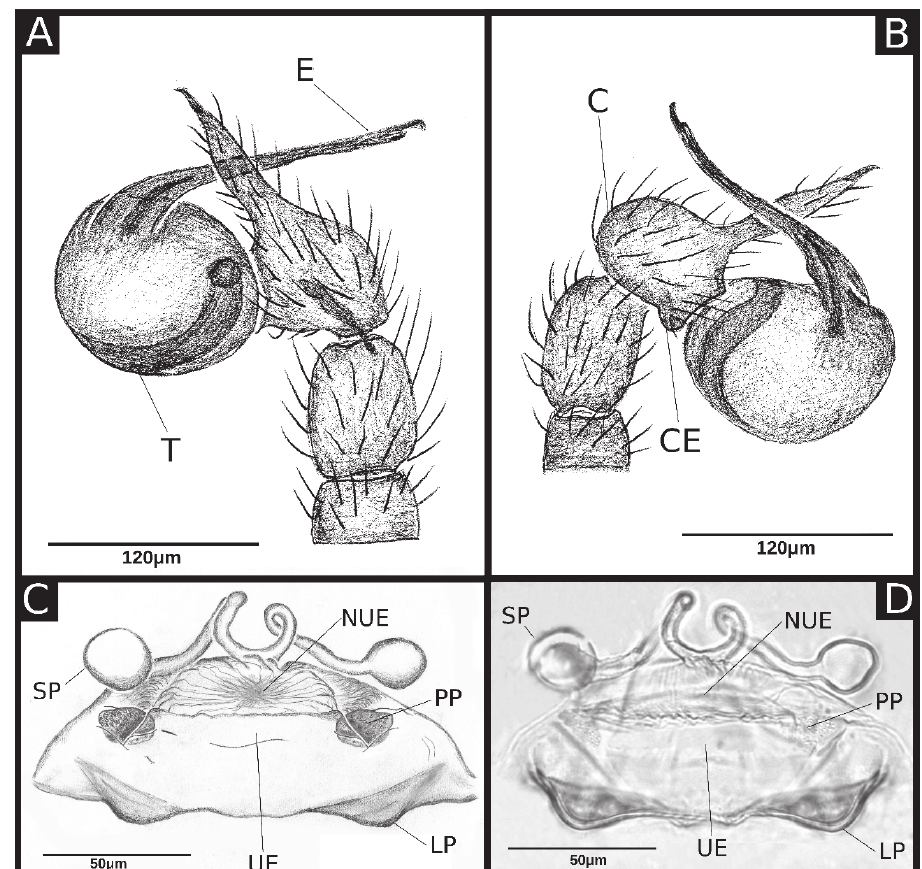
Figure 5. Ochyrocera dorinha sp. nov., A left male palp (IBSP 186100), retrolateral view B same, prolat- eral C female genitalia (IBSP 189185), enzyme cleared, dorsal view D same, dorsal view. Abbreviations: C, cymbium; CE, cymbial extension; E, embolus; LP, lateral pockets; NUE, neck of uterus externus; PP, pore-plate; SP, spermathecae; T, tegulum, UE, uterus